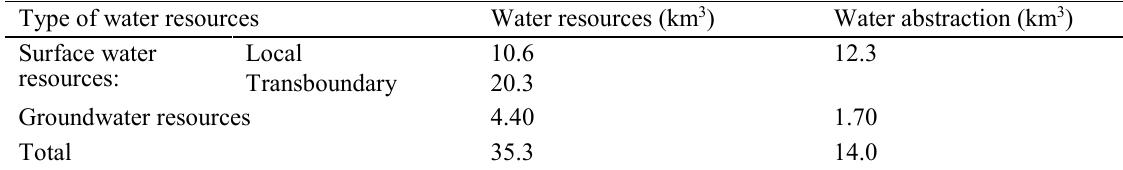
Table 1 Water resources and water abstraction of the Azerbaijan Republic. Type of water resources Surface water